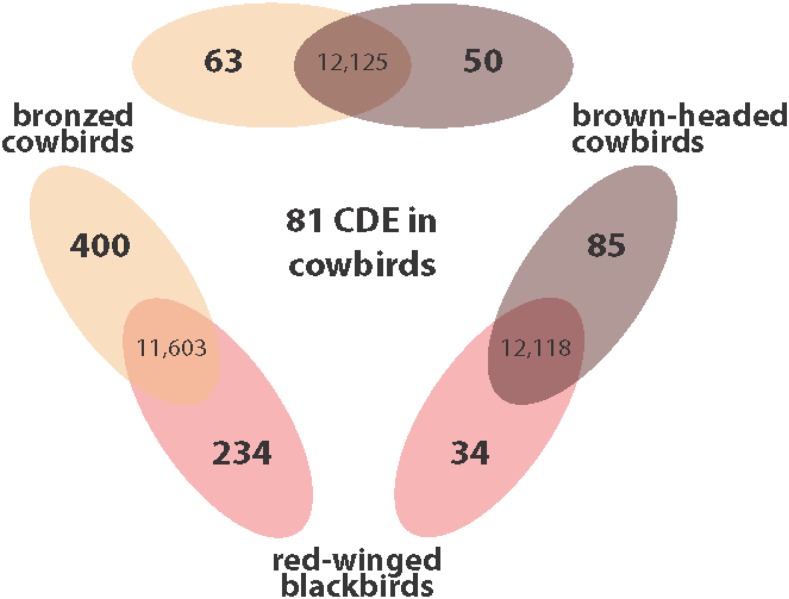
Differential gene expression comparisons between parasitic cowbirds and non-parasitic red-winged blackbirds. Transcripts differentially expressed in pairwise comparisons between species are shown in Venn diagrams with the number of differentially expressed transcripts on the edges and the number of non-differentially expressed transcripts in the overlap. The number of genes closer to a given species indicates those transcripts that were significantly upregulated in that species. Eighty-one transcripts were concordantly differentially expressed (CDE) in parasitic cowbirds as compared to non-parasitic red-winged blackbirds. We suggest these CDE transcripts are those transcripts most likely to be involved in the evolution of brood parasitism.